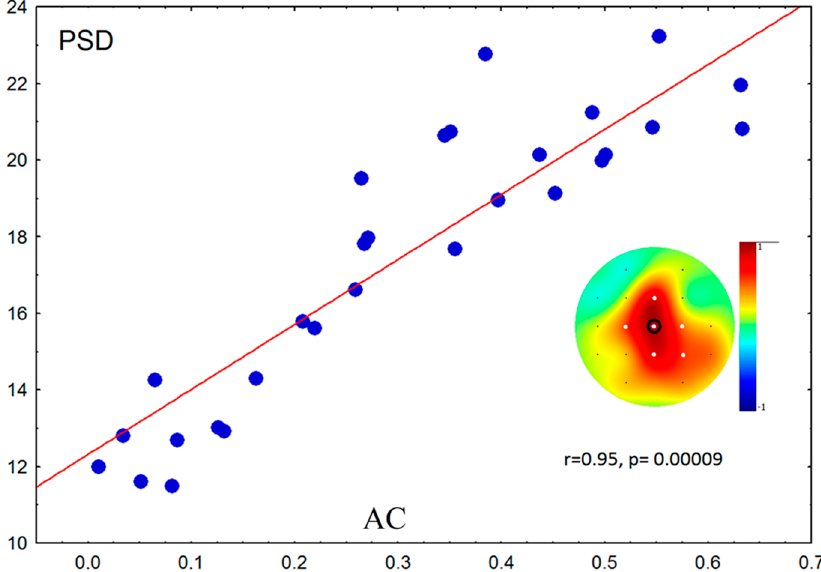
Figure 2. Scatterplot of power spectral density (PSD) data (2–4 Hz) against asymmetry of the blood flow in carotid arteries (AC) in children. White dots—significant correlations after Bonferroni correction and permutation test; black circle—electrode used for scatterplot.